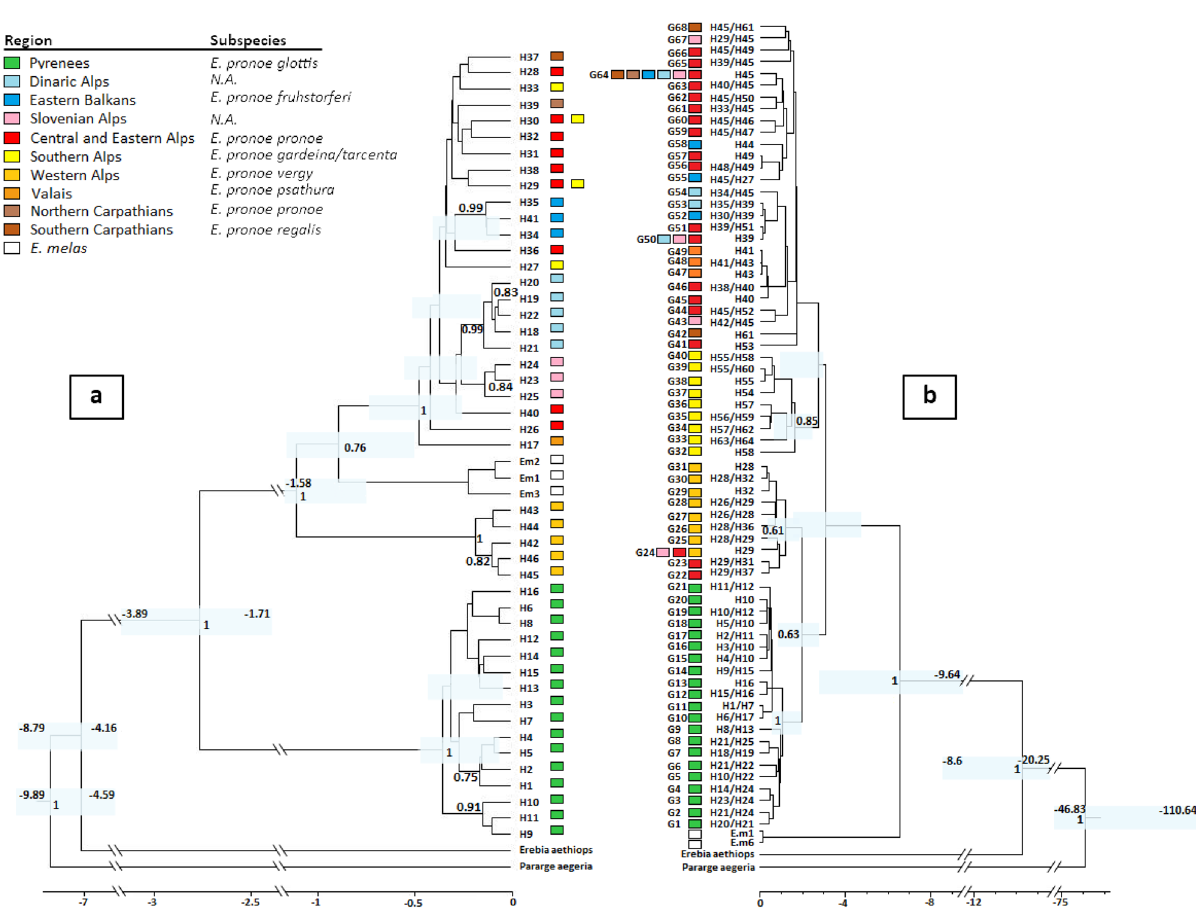
Figure 3. Bayesian phylogeny based on concatenated ( a ) mtDNA haplotypes (COI, NDI) and ( b ) nuclear haplotypes (EF1α, RPS5) of Erebia pronoe . Numbers next to the nodes: Bayesian posterior probabilities > 0.7; light blue node bars: 95% highest posterior density of node ages (age is explicitly given as number if bar includes a cut in the timeline). The colour codes of each region and the corresponding subspecies are given in the legend (N.A. = no subspecies name available for this region). The reference haplotypes of E. melas are given in white. The geographical location of the haplotypes is given in the same colours as in Fig.